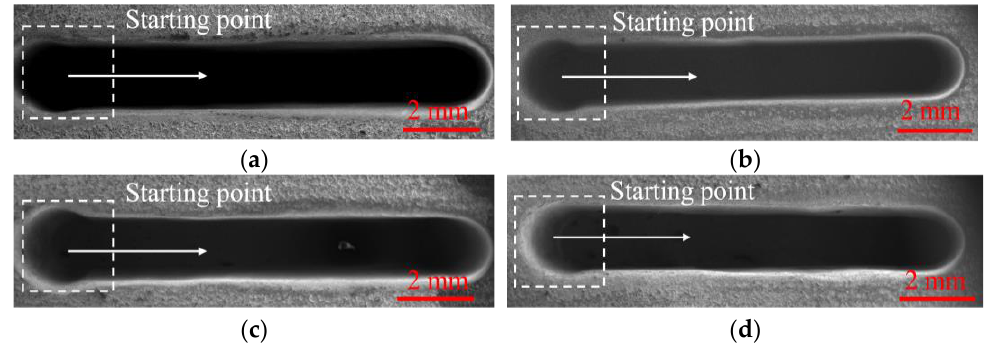
Figure 9. The SEM images of DNGs machined with different wedged angles in the end face of tube electrode. ( a ) Wedged angle = 0°; ( b ) wedged angle = 40°; ( c ) wedged angle = 50°; ( d ) wedged angle = 60°.